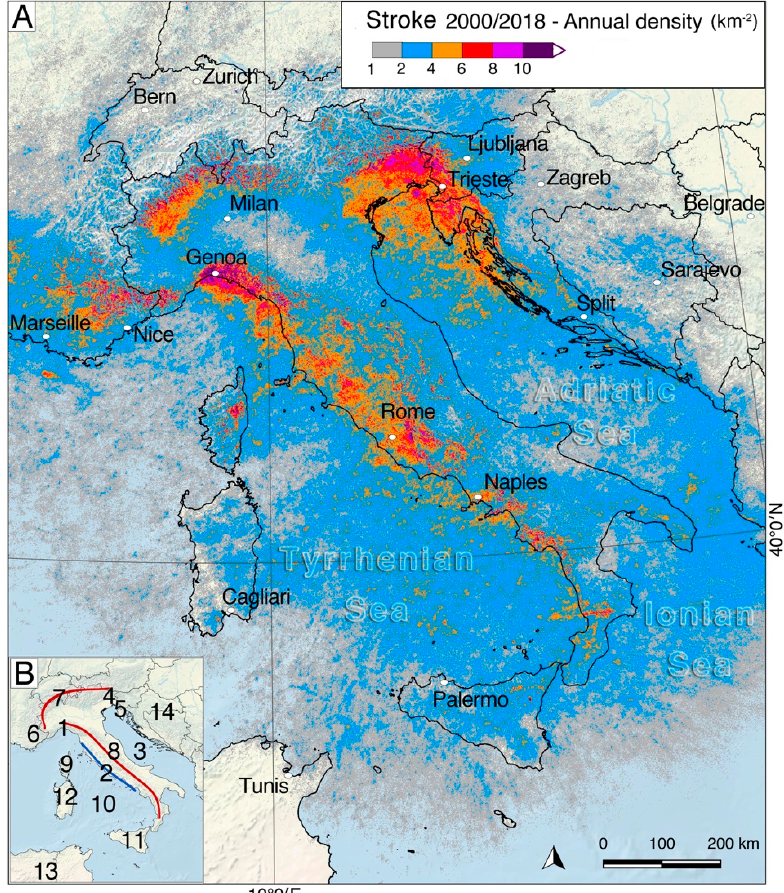
Figure 1. ( A ) Studied area and annual stroke mean per square km calculated for the 2000–2018 period; ( B ) higher densities along: 1. the central Liguria coastline, 2. (blue line), the Tyrrhenian coastline, 3. the northern Adriatic Sea, 4. Northeast Italy, 5. the Capodistrian peninsula, 6. Provence in France, 7. (red line), the Central Italian Alps, 8. (red line) the Apennines, and 9. inner Corsica. Other cited areas: 10. Tyrrhenian Sea, 11. Sicily, 12. Sardinia, 13. northern Atlas, and 14. the western Balkan